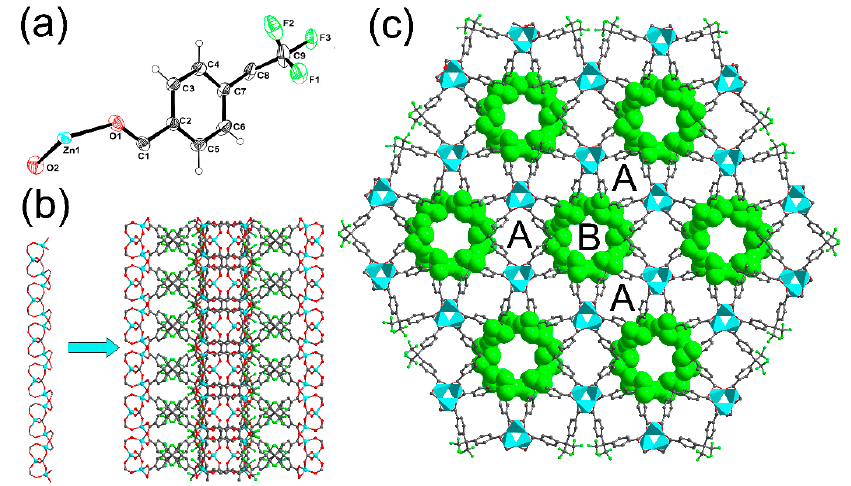
Figure 1. Crystal structure of Zn(hfipbb): ( a ) asymmetric unit (at 50% probability); ( b ) helical chain and the framework view along [100] direction; ( c ) the framework viewed along [001] direction showing channels A and B (Zn: turquoise polyhedral; F: green sphere).